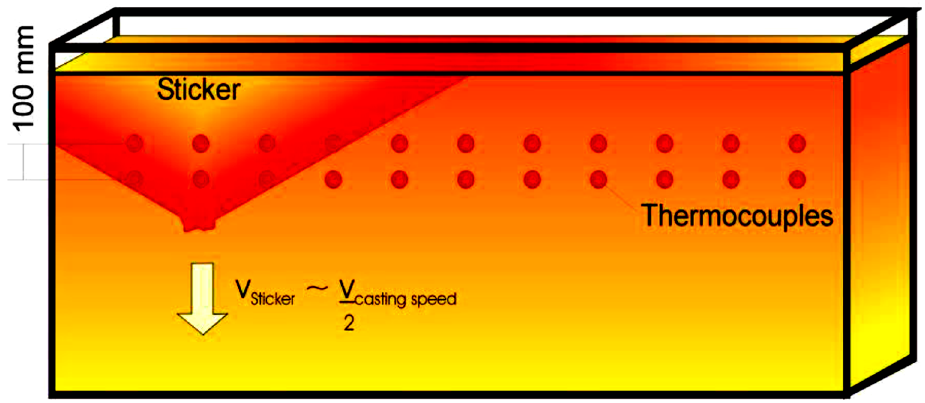
Figure 3. Sticker development in the mold.